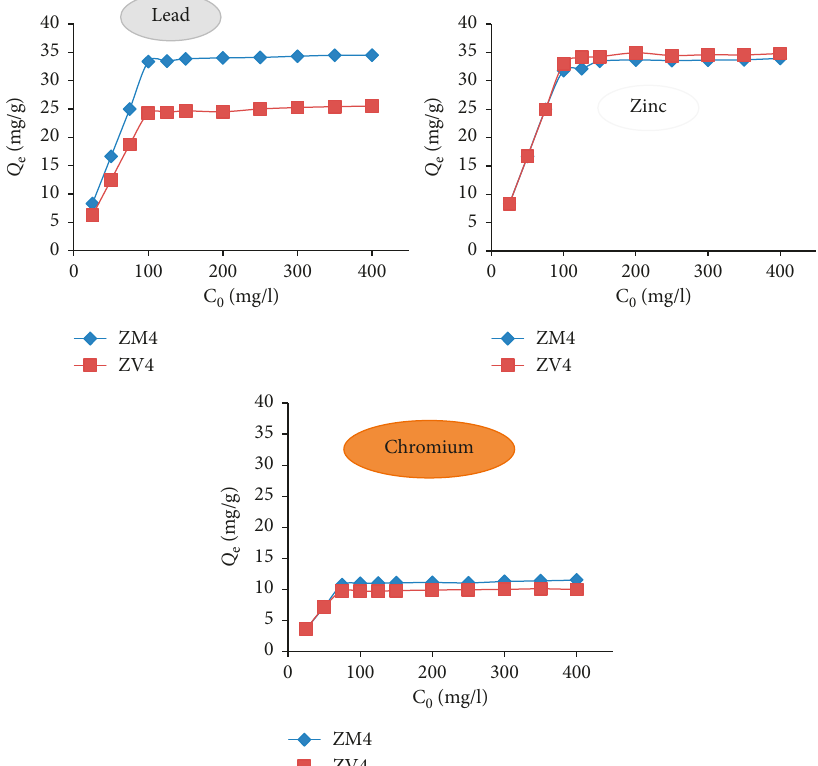
Figure 10: Effect of initial metal concentration on the adsorption of heavy metals onto ZV4 and